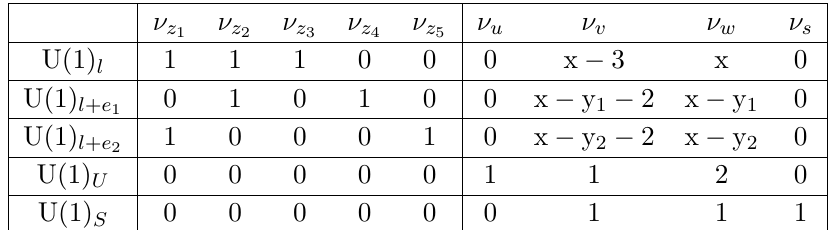
Table 3 . GLSM data for Bl 1 P 2